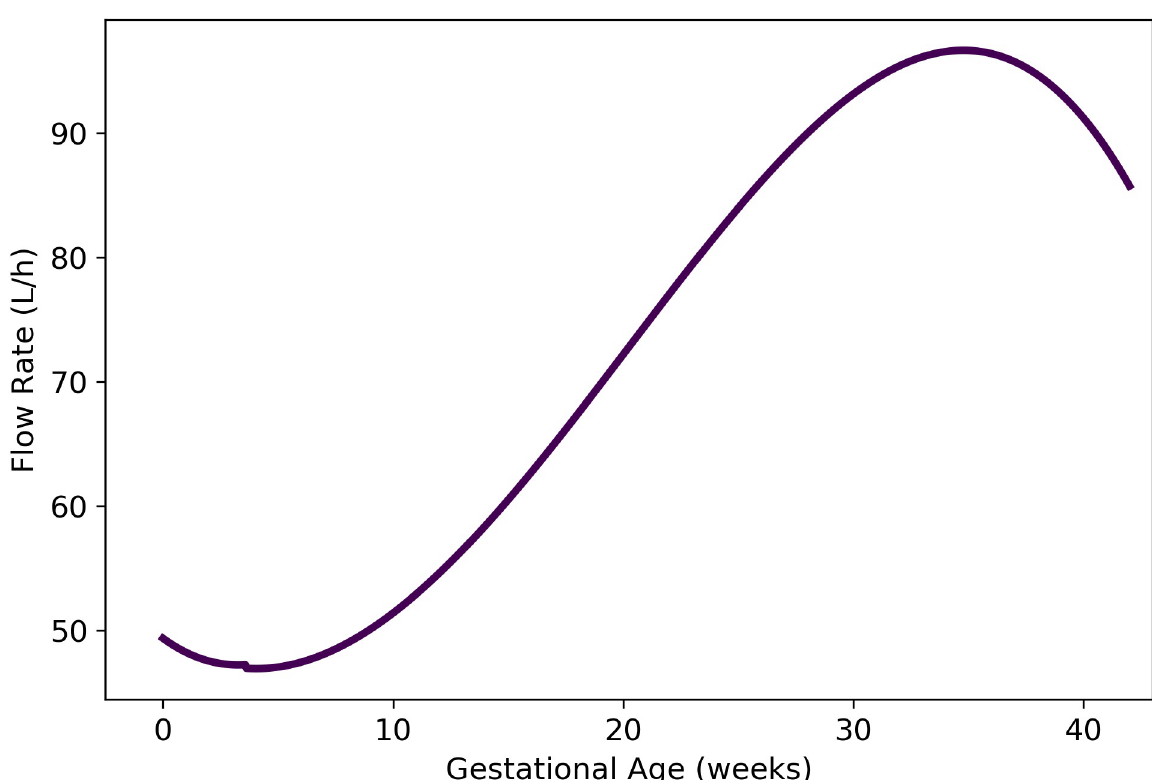
Fig 12. Maternal blood flow to the “rest of body” compartment vs. gestational age (cf. Eq 23).